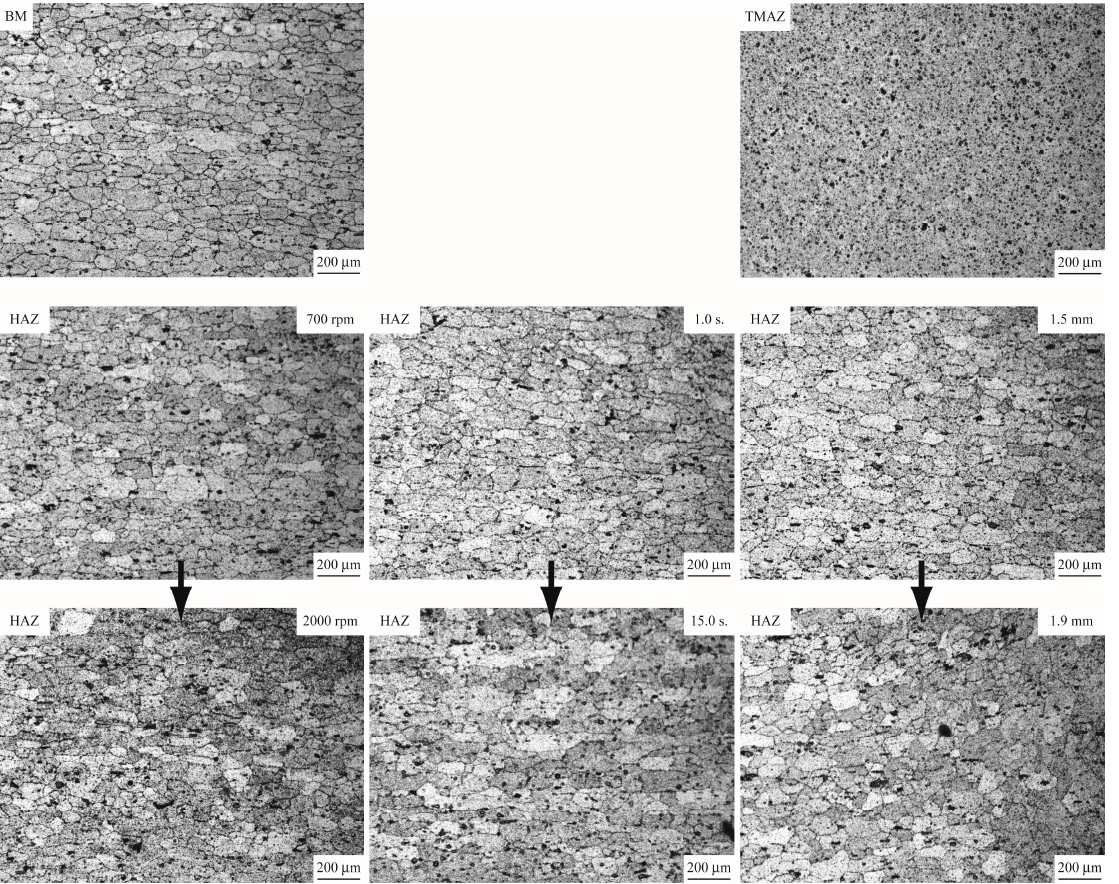
Figure 13. Optical micrographs of BM, TMAZ, and HAZ in welds made by T2 tool at processing parameters listed in Table 3.